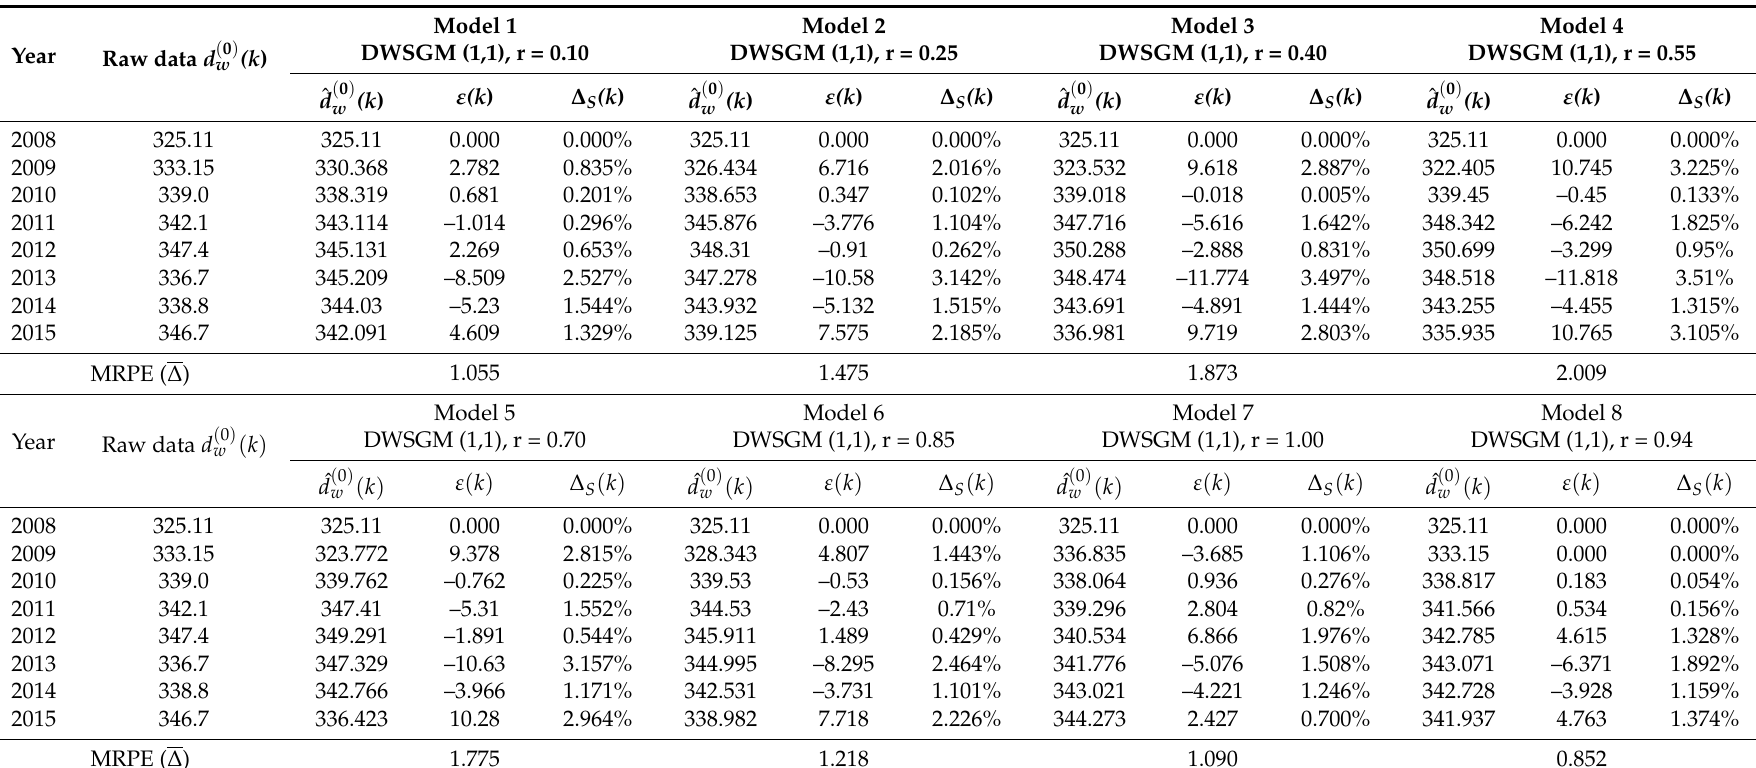
Table 3. Simulated/forecasted values and errors of the DWSGM (1,1) model with different